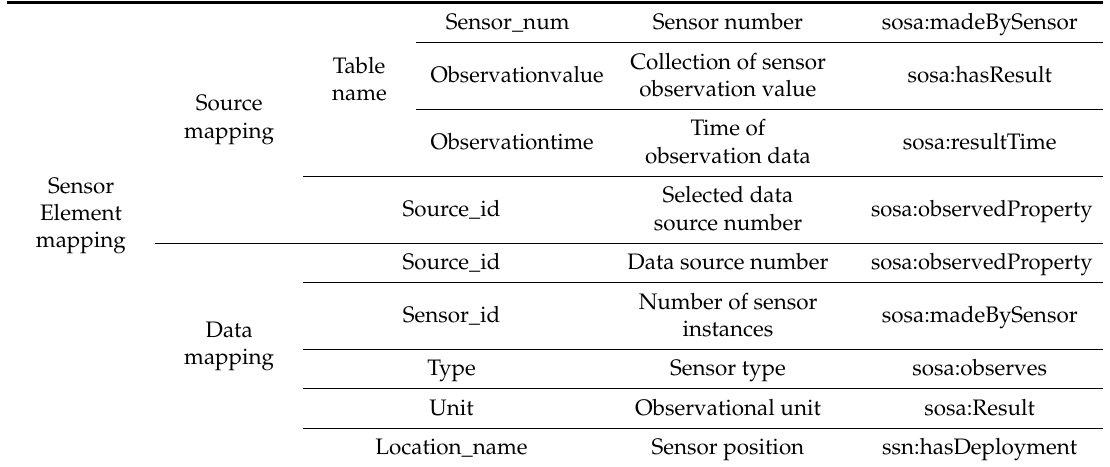
Table 1. Sensor Element Mapping.